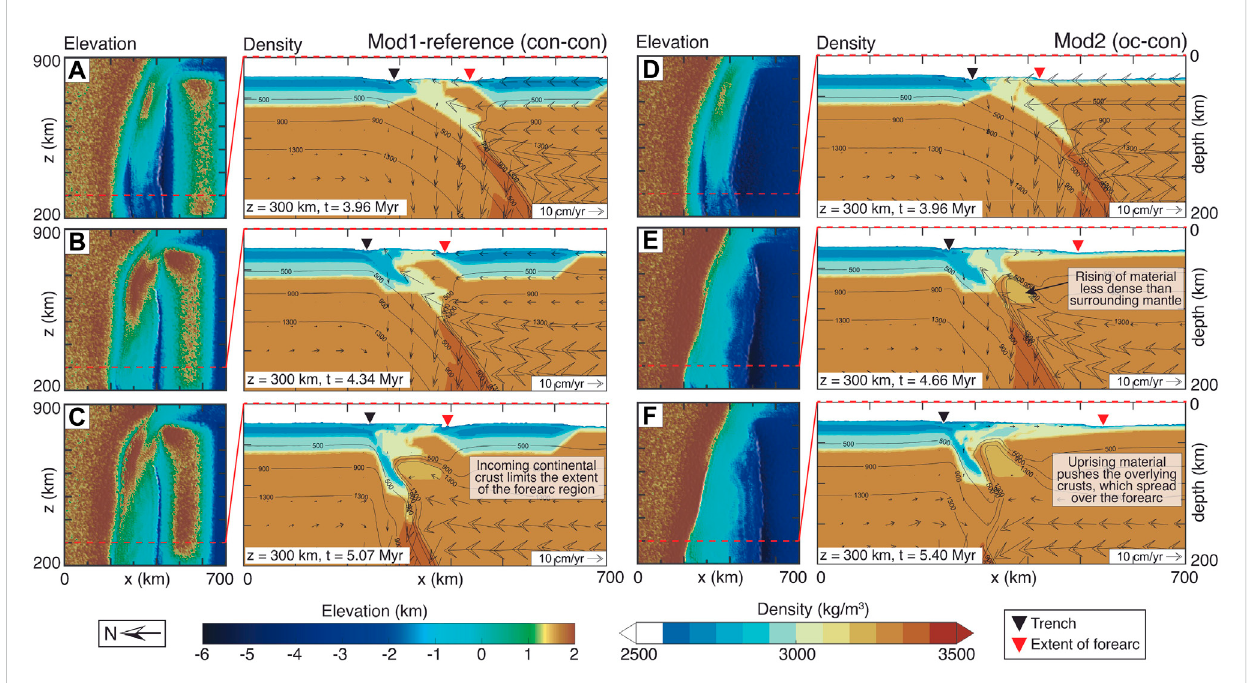
FIGURE 6 Elevation and density evolution for model Mod1-reference (A,B,C) and Mod2 (D,E,F) . The density cross-sections are taken from z = 300 km, shown as a red dashed line on each corresponding elevation plot. The black triangle indicates theposition of the trenchand the red triangle indicates the extent of the forearc. In both models, a body of less density (3,200 kg/m 3 ) than the surrounding mantle exhumes up the subduction channel (C,E,F) . The exhumed material thrusts under the overlying crust leading to a raised elevation. In Mod1, the buoyant incoming continental crust (right, southern sideof the model)limits theextent ofthe forearc region to the area in-between thepassive margin and the incoming continental crust. InMod2, thelack of a buoyant continental crust allows the crustal material, which are pushed up by mantle exhumation, to spread over a wider area and extending the forearc